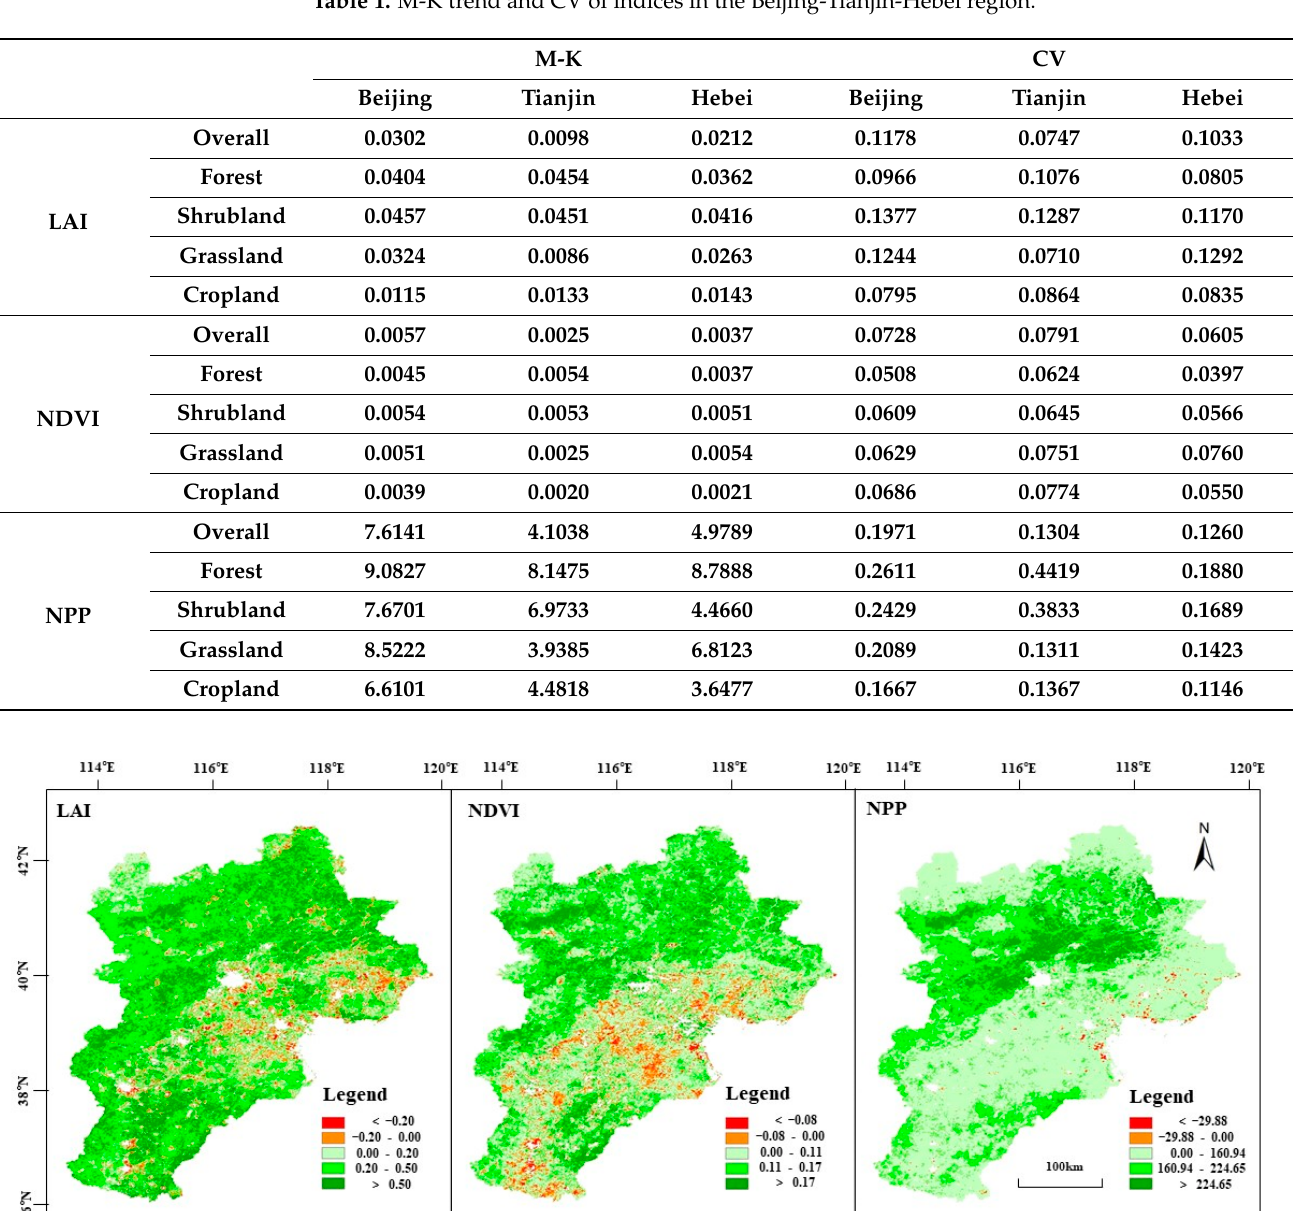
Table 1. M-K trend and CV of indices in the Beijing-Tianjin-Hebei region.